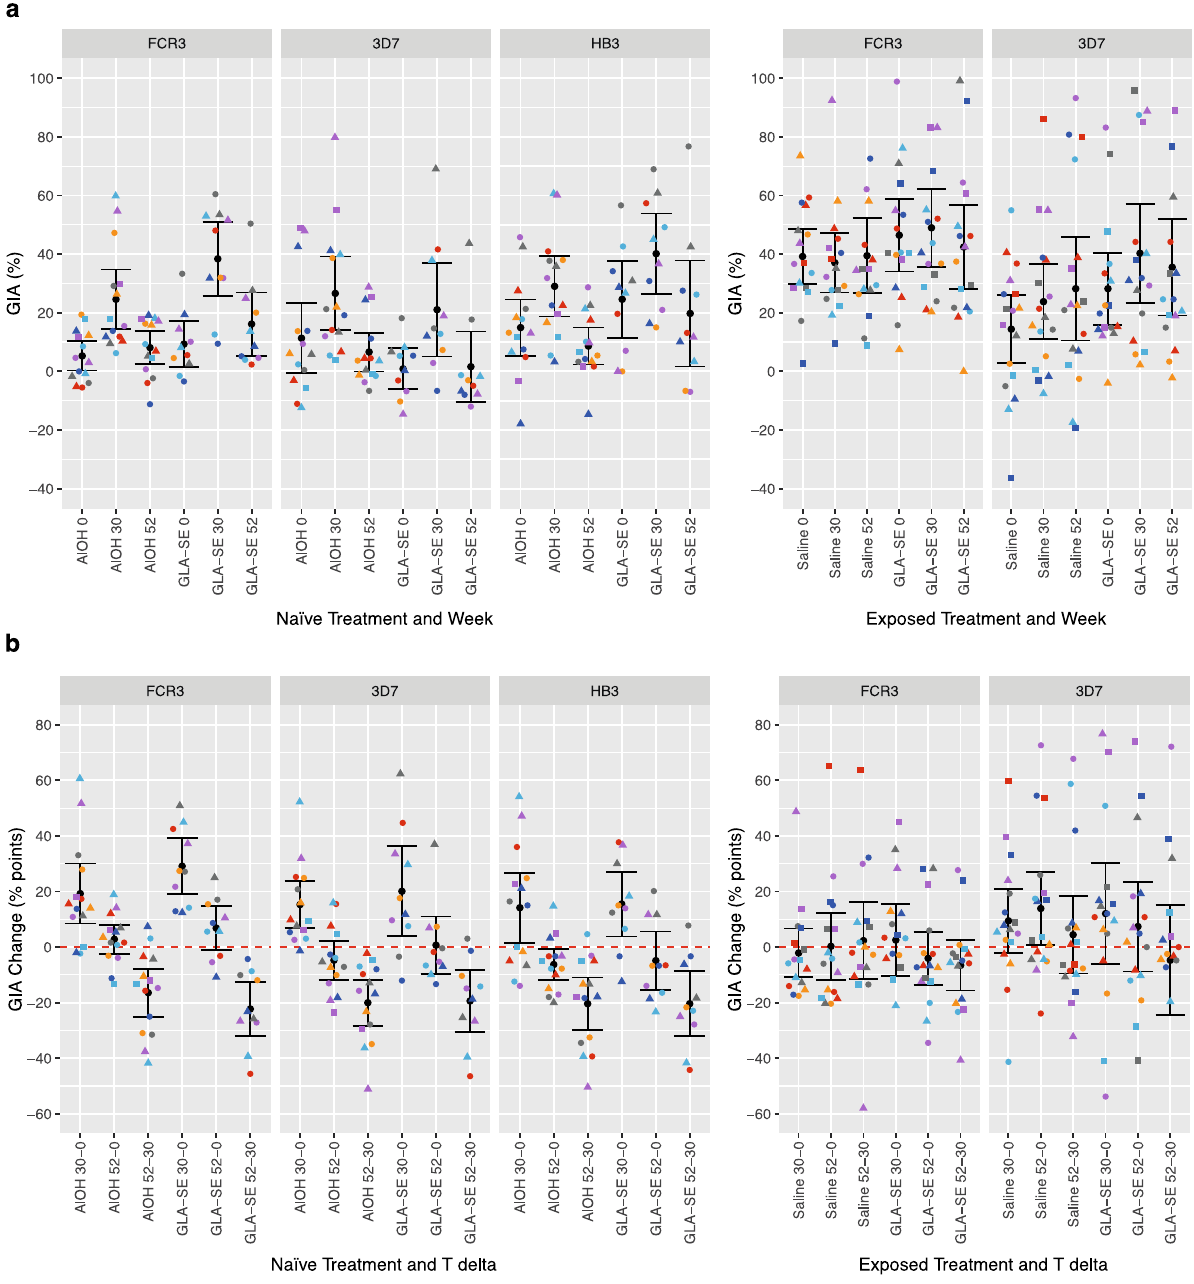
Fig. 2 GIA levels and responses before vaccination, and four and 22 weeks after the third vaccination. a GIA levels at weeks zero, four and 22 weeks after the third vaccination and b GIA level changes following vaccination. Colours and shapes within treatment groups indicate individual subjects. Summary statistics (arithmetic means with 95% con fi dence intervals) are shown in every panel. The red dashed line in the GIA level change indicates no change in GIA level (post/pre-vaccination =